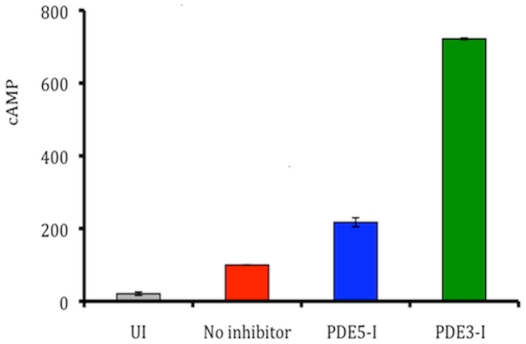
Intracellular cAMP levels increase within M.tb.-infected THP-1 human monocytic cells upon exposure to PDE-Is.The treated infected cells received 100 uM of PDE inhibitors (PDE-I 3, and 5 class) for 2 h followed by infection. UI: uninfected cells; the PDE5-I was 4-{[3′,4′-(Methylenedioxy)benzyl]amino}-6-methoxyquinazoline (MBM); and the PDE3-I was trequinsin. Results shown (mean and SD) represent two biological replicates, each with 2 technical replicates.